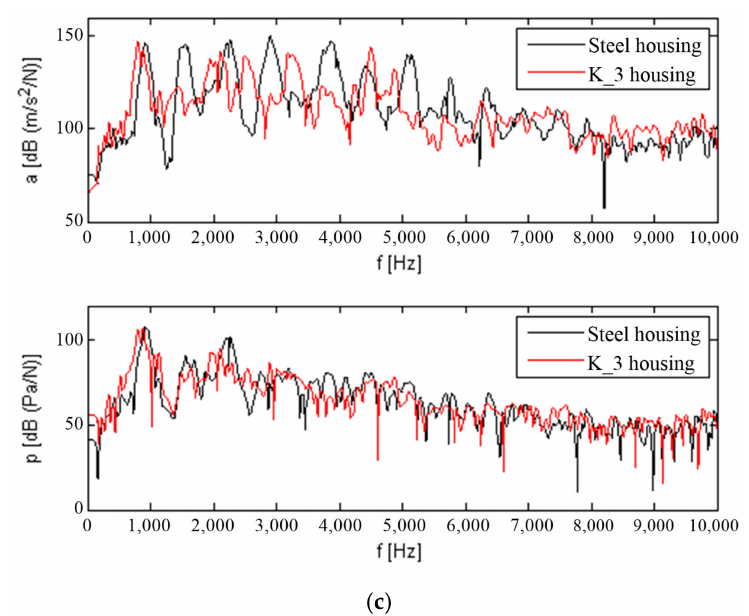
Figure 9. Comparison of averaged vibration acceleration (a) and sound pressure (p) of composite housings and steel housing: ( a ) Steel housing-K_1 housing, ( b ) Steel housing-K_2 housing, and ( c ) Steel housing-K_3 housing. Table 3. Change in the vibration level of housings K_1–K_3, relative to the steel housing. Change in Vibration Level [dB]